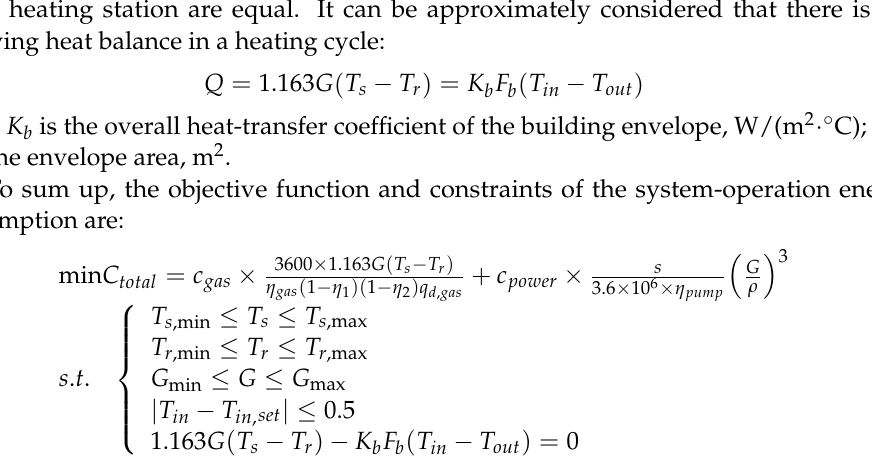
Manipulated parameters Secondary water supply temperature: T